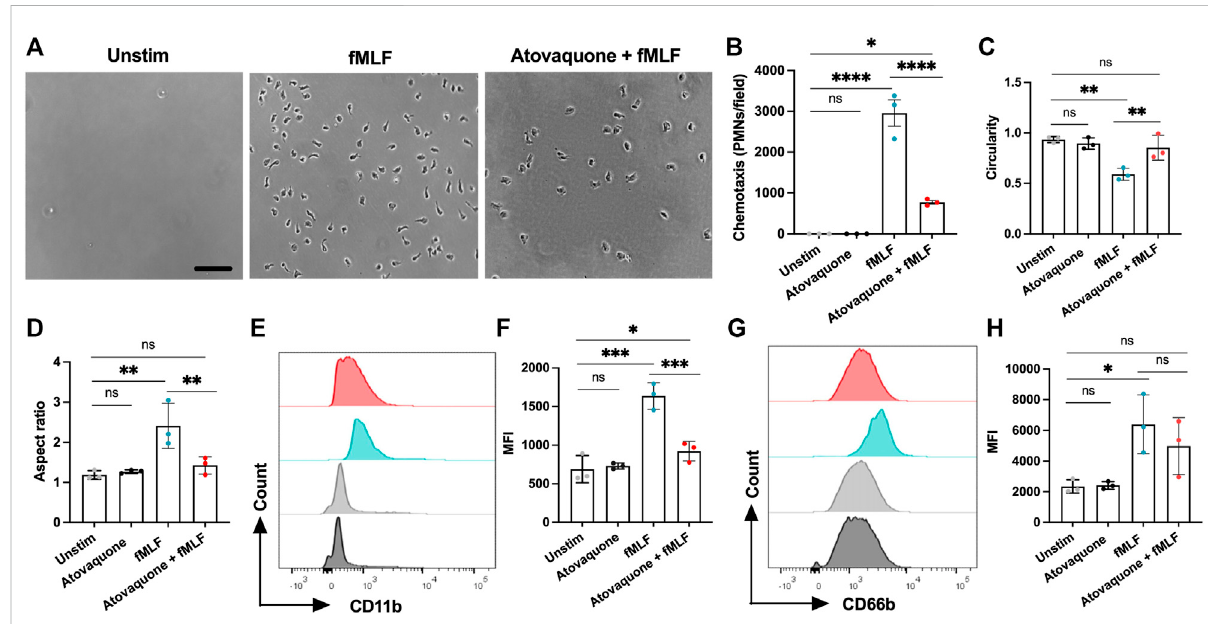
FIGURE 5 Atovaquone negatively regulates human neutrophil chemotaxis by downregulating CD11b expression. (A – D) Freshly isolated human neutrophils were induced to migrate across permeable supports by introduction of the fMLF gradient. (A) Representative bright fi eld images (the bar is 50 μ m) and (B) Quanti fi cation of neutrophils following chemotaxis in the bottom chamber with/without pre-treatment with atovaquone. At least 7 fi eldsperconditionwerequanti fi edfrom3independentexperimentsthatwereperformedinduplicates. Dataareshownasanaveragedvalue of all fi elds in both duplicates. (C,D) Analyses of neutrophil polarization [indexed by (C) circularity and (D) length to width ratio] following chemotaxis with/withpre-treatmentwithatovaquone.Atleast7 fi eldsperconditionwerequanti fi edfromN=3independentrepeatsinduplicates. (E – H) Human neutrophils, untreated or pre-treated with atovaquone were stimulated with fMLF (200 nM, 30 min). (E,F) Representative fl ow diagram and quanti fi cation of mean fl uorescence intensity (MFI) of surface CD11b. (G,H) Representative fl ow diagram and MFI quanti fi cation of surface CD66b. N = 3 independent repeats using 3 different donors. * p < 0.05, ** p < 0.01, *** p < 0.001, **** p < 0.0001, ns, not signi fi